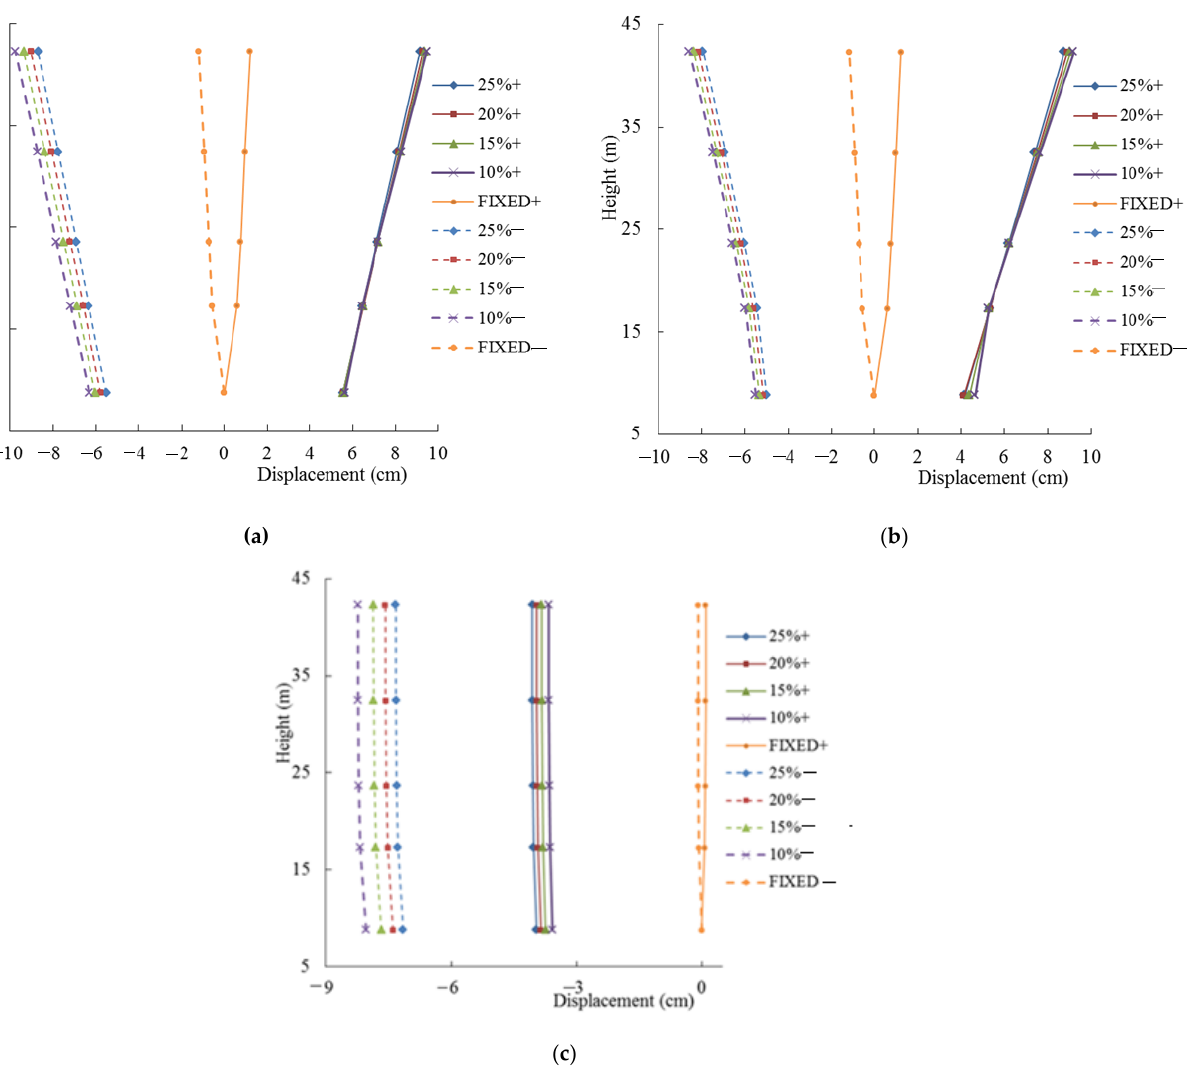
Figure 14. Comparison of the peak displacement response of the internal structure ( a ) In the horizontal direction X ; ( b ) In the horizontal direction Y ; ( c ) In the vertical direction Z.